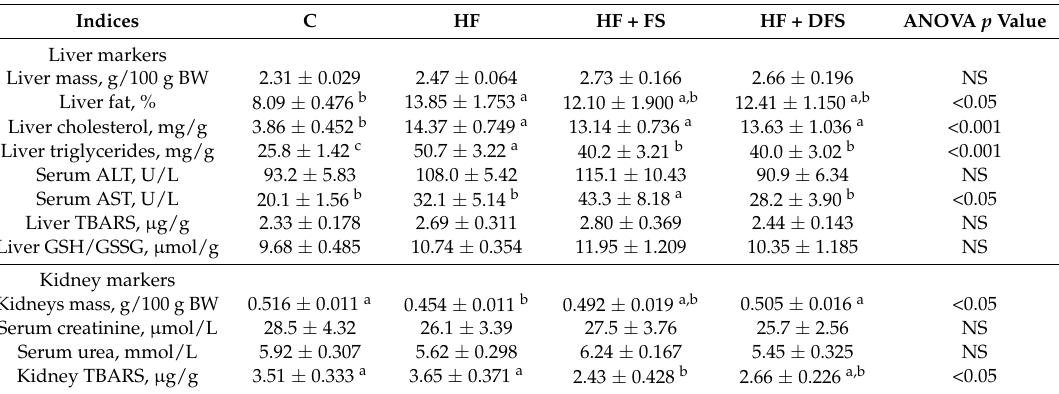
Table 3. Markers of liver and kidney functions in rats.